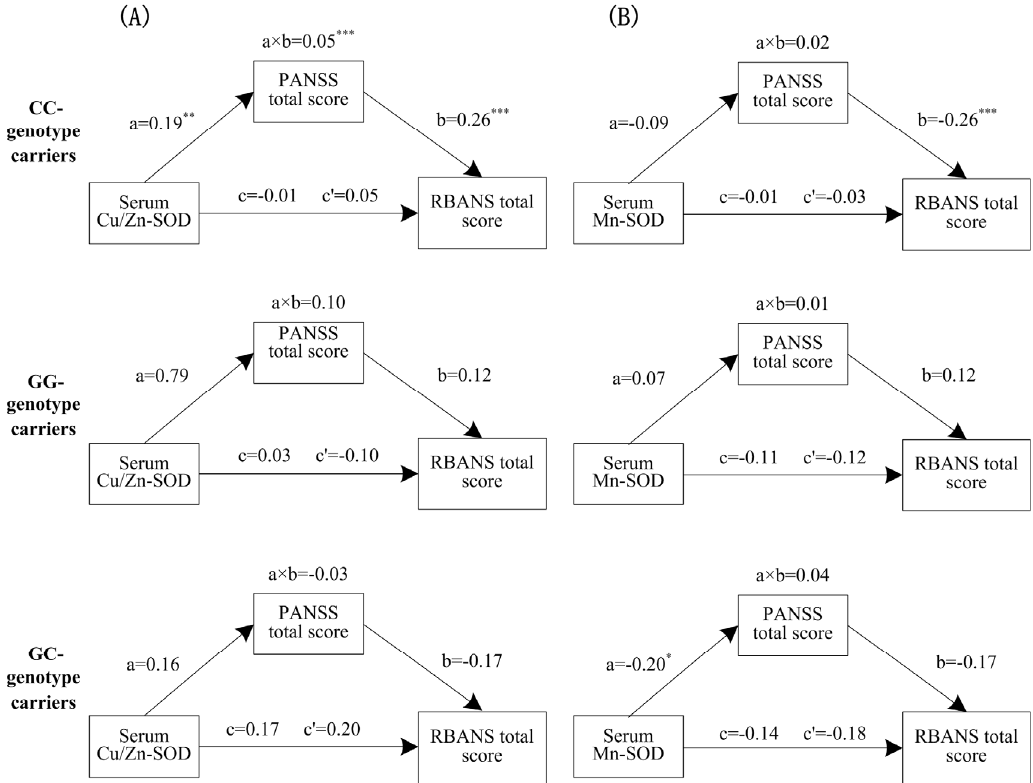
Figure 2. Mediation path analysis among serum Cu/Zn–SOD or Mn–SOD, psychotic symptoms and cognition varied with transferrin rs3811655 polymorphism. ( A ): Mediation model of serum Cu/Zn–SOD via psychotic symptoms on cognition. ( B ): Mediation model of serum Mn–SOD via psychotic symptoms on cognition. a × b: the indirect effects of oxidative stress on cognition; c = the total effects of oxidative stress on cognition; c’ = the direct effects of oxidative stress on cognition; a = the effects of oxidative stress on psychotic symptoms; b = the effects of psychotic symptoms on cognition. * p < 0.05, ** p < 0.01, *** p <